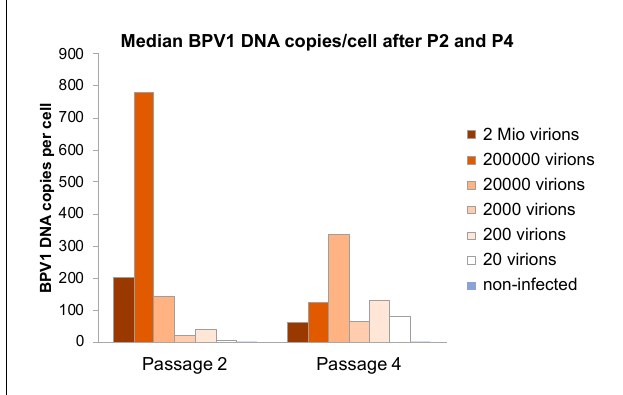
Figure 3. After four passages, BPV1 DNA loads settled at around 150 copies per cell. Medium BPV1 DNA loads were determined by E2 qPCR for ArcAi-1 at P2 and P4. The different colors of the bars represent respective amounts of virions used for initial infection as specified by the corresponding legend on the right side of the graph.